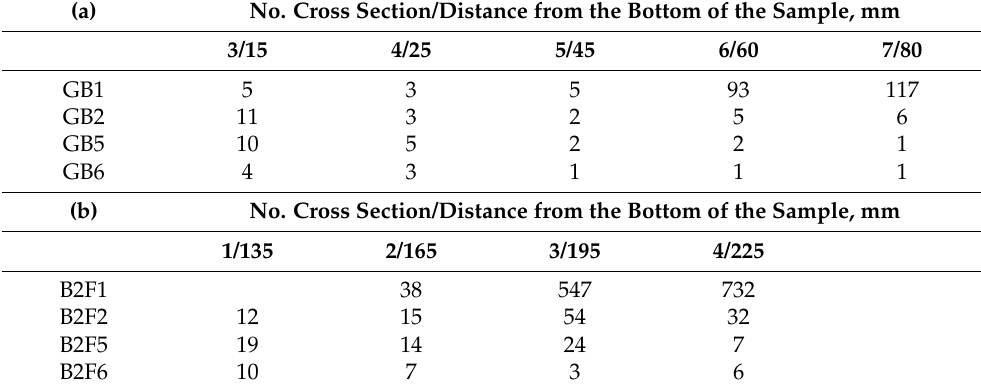
Table 4. (a). Measured grain number, GB samples; (b). Measured grain number, B2F samples. (a) No. Cross Section/Distance from the Bottom of the Sample, mm